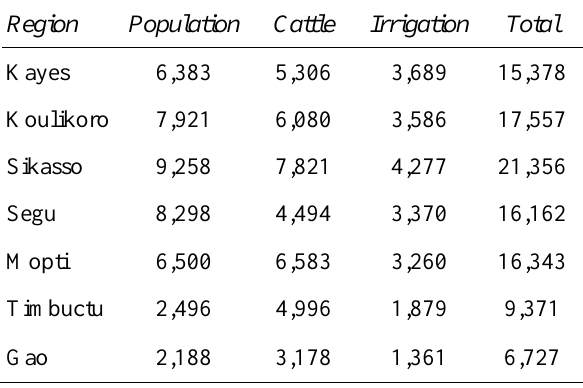
Table 1: Regional distribution of water use in Mali - Exploitation of subterranean water estimated by region for 1989 in 000, cubic meters Region Population Cattle Irrigation Total